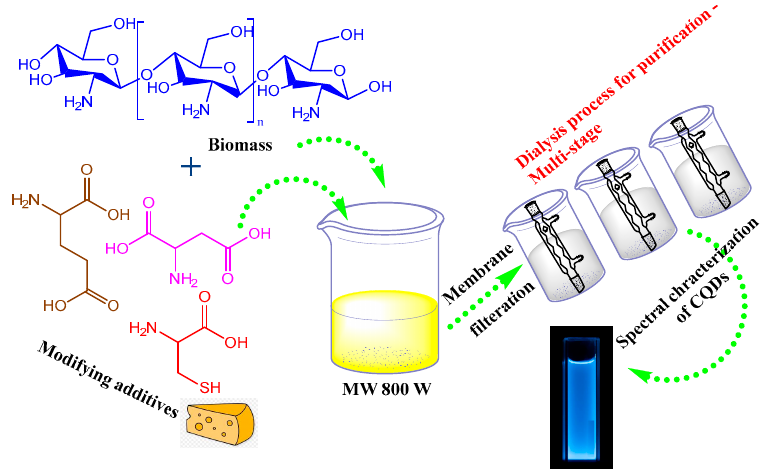
Figure 8. N-doped CQDs green synthesis from biopolymeric chitosan.